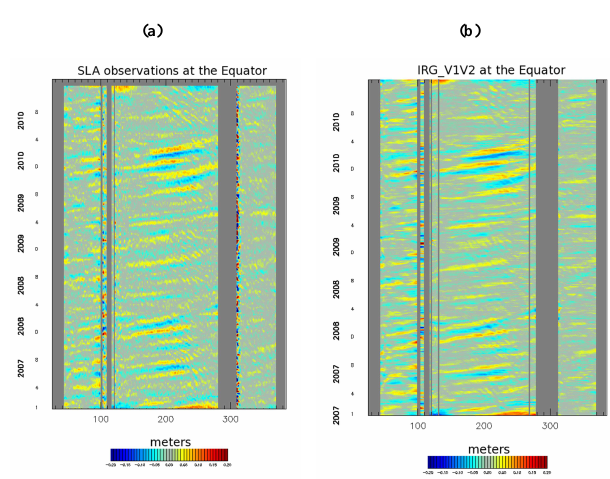
Fig. 22. SLA longitude–time diagrams at the Equator over the world ocean. SLA from AVISO DUACS MyOcean SL TAC (a ) and from IRG V1V2 (b) are high-pass filtered to keep fluctuations at periods shorter than 128 days.